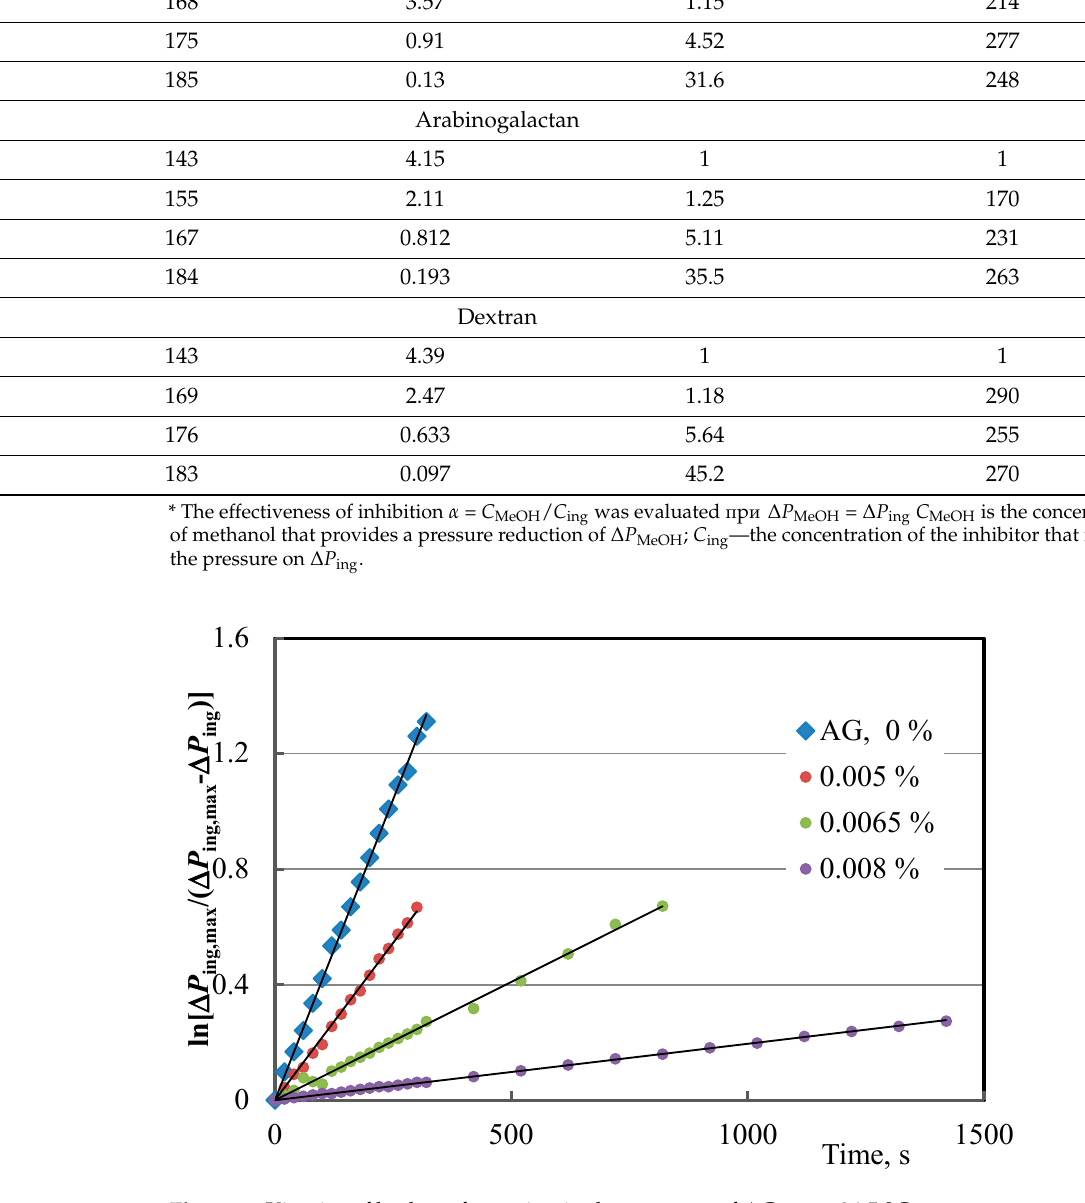
Figure 9. Kinetics of hydrate formation in the presence of AG at t = 24.5 ◦